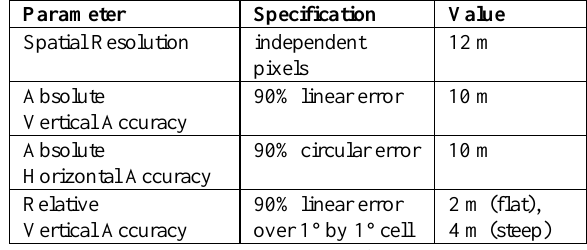
Table 1. TanDEM-X Final DEM